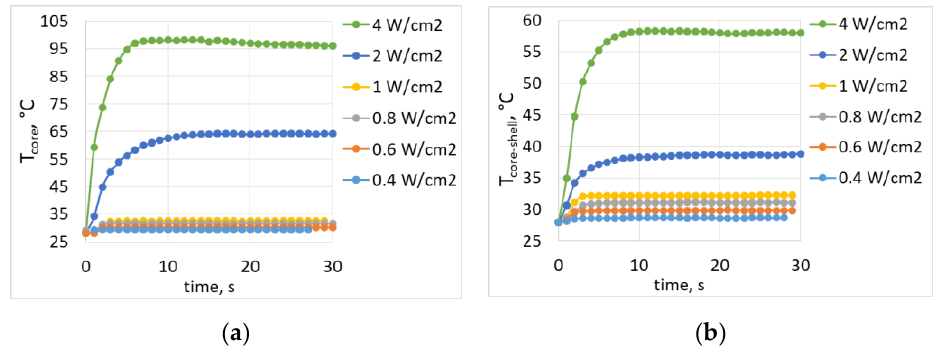
Figure 3. The influence of pump power density on heating temperature of ( a ) core NaGdF 4 :Yb 3+ , Ho 3+ , Er 3+ NPs and ( b ) core-shell NaGdF 4 :Yb 3+ , Ho 3+ , Er 3+ NPs. Er 3 + NPs and ( b ) core-shell NaGdF 3 + , Ho 3 + , Er 3 + NPs. 4 :Yb